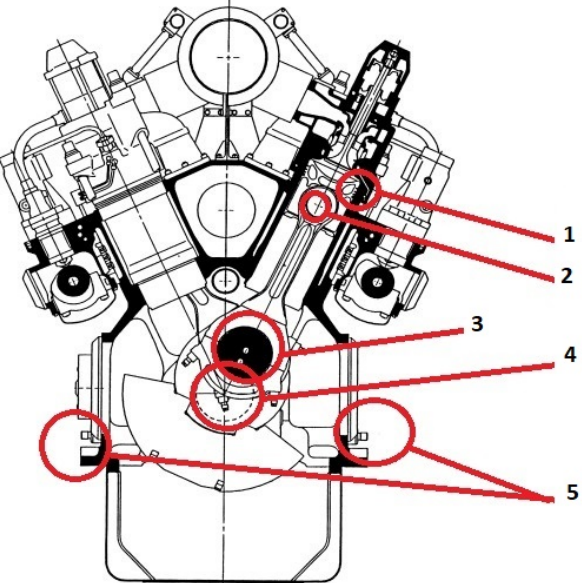
Figure 2. Components of a V-shape trunk type engine and its surroundings that can cause an explosion in the crankcase [11]: 1—cylinder liner, piston, piston rings; 2—gudgeon pin bearing; 3—crank pin bearing; 4—main bearing; 5—engine environment.